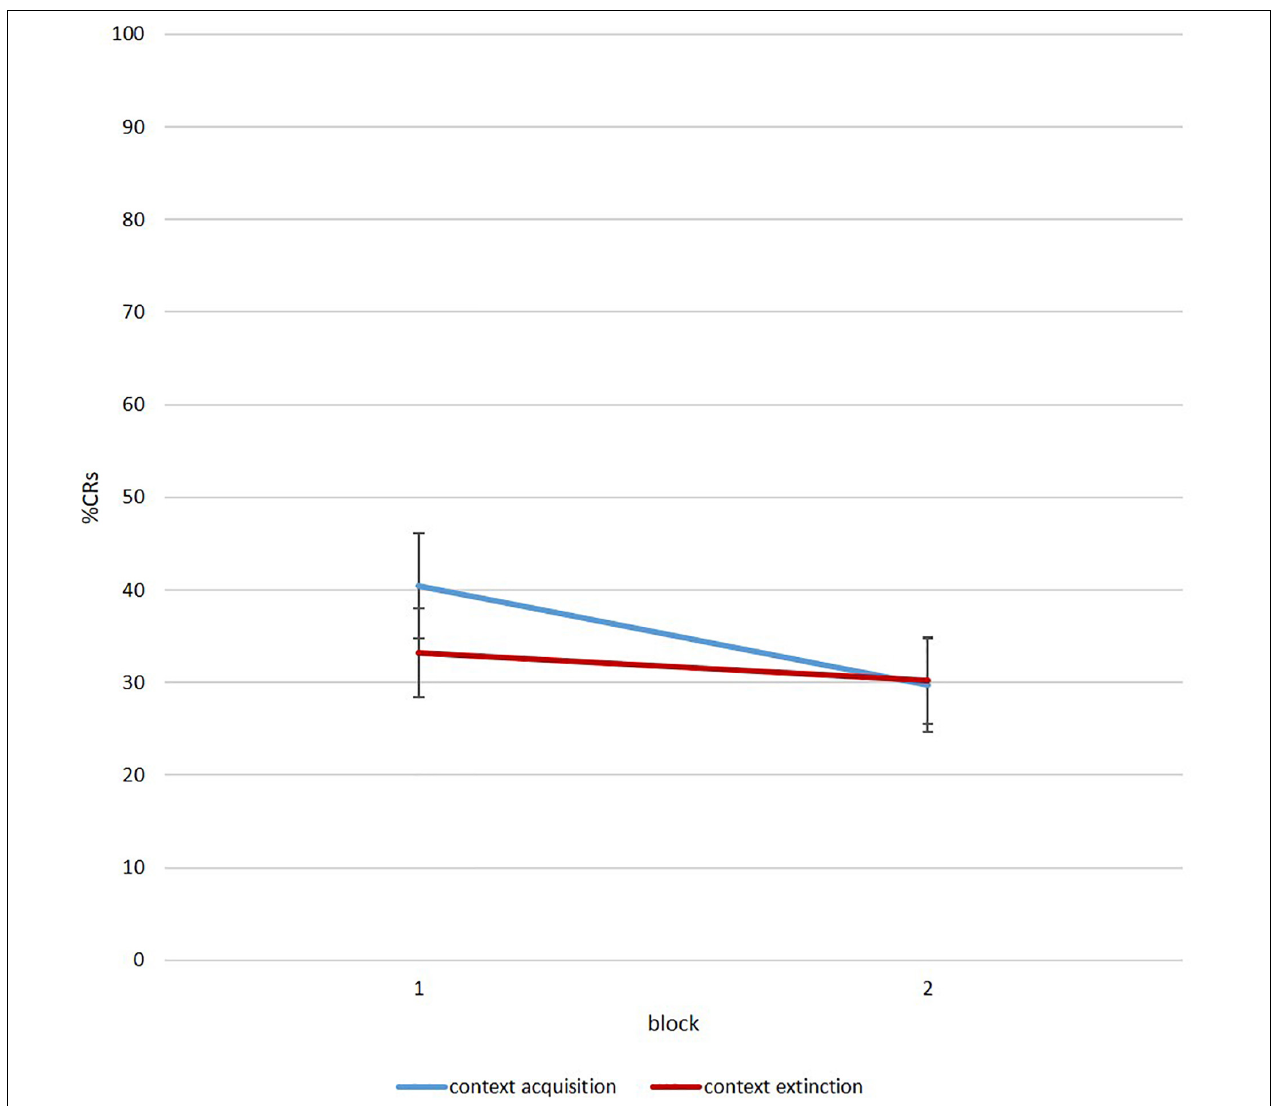
FIGURE 7 | Mean percent CR for six-trial blocks during renewal in the acquisition (blue) and extinction context (red) ( N = 40 of which n = 25 infants and adolescents/adults: n =